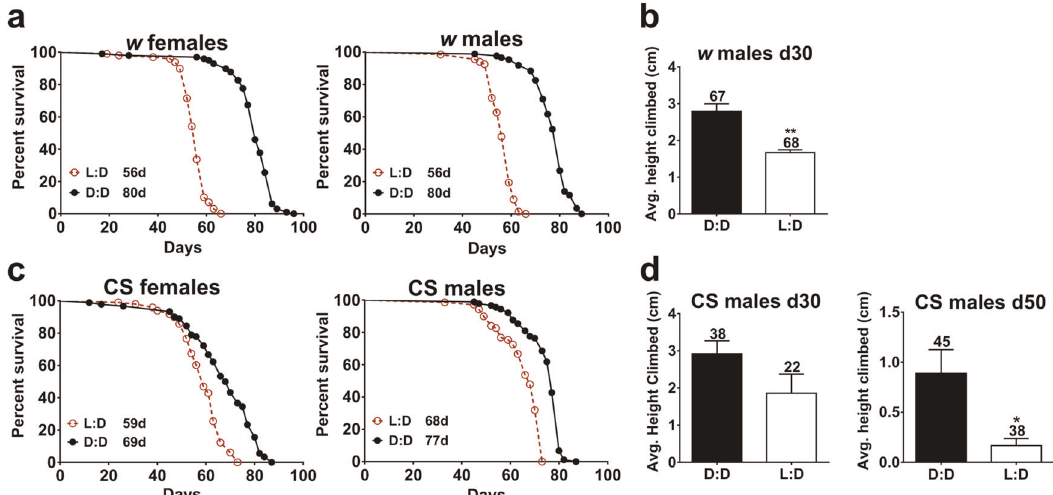
Fig. 1 White fl uorescent light shortens fl y lifespan and decreases mobility. a Adult white ( w ) fl ies aged in constant darkness (D:D) have a signi fi cantly extended lifespan compared with those aged in white fl uorescent light (L:D) (Log-rank test, p < 0.0001). b Average climbing ability was signi fi cantly lower in 30-day-old w males kept in L:D versus those kept in D:D (unpaired t test, p = 0.0066). c Canton S (CS) adult fl ies aged in D:D have a signi fi cantly extended lifespan compared with those aged in L:D (Log-rank test, p < 0.0001). d Average climbing ability was lower but not signi fi cant in 30-day-old CS males kept in L:D versus those kept in D:D, and signi fi cantly lower in 50-day-old CS males kept in L:D versus those kept in D:D (unpaired t test, p = 0.0434). For longevity experiments in ( a , c ), N = 100 for each genotype and light condition. Numbers above bars indicate the sample size in each light condition. Error bars show standard error of the mean